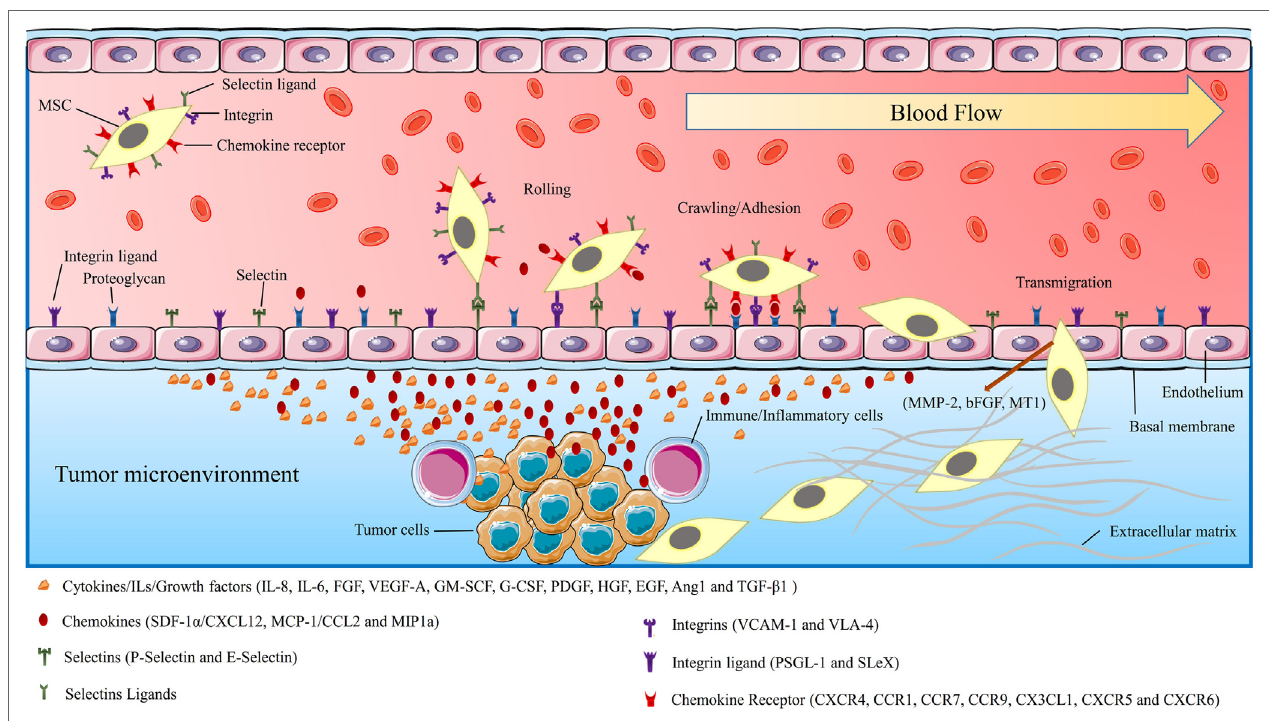
FiGURe 2 | The schematic picture shows the mechanism of mesenchymal stromal/stem cells (MSCs) migration/homing toward injured/cancer tissues. MSCs moving toward target tissue can be characterized by three stages: flowing through blood-flow, moving toward chemoattractants, and adhesion by surface receptors, translocation from blood flow toward injured/cancer tissue. The figure also demonstrates the endothelial–MSCs interactions, receptors, and the chemokines which are involved in MSCs migration procedures. The tumor-affected endothelial cells produce selectins, integrin ligands, and chemokines. These secretory stimulants and chemoattractants recruited MCSs to the tumor